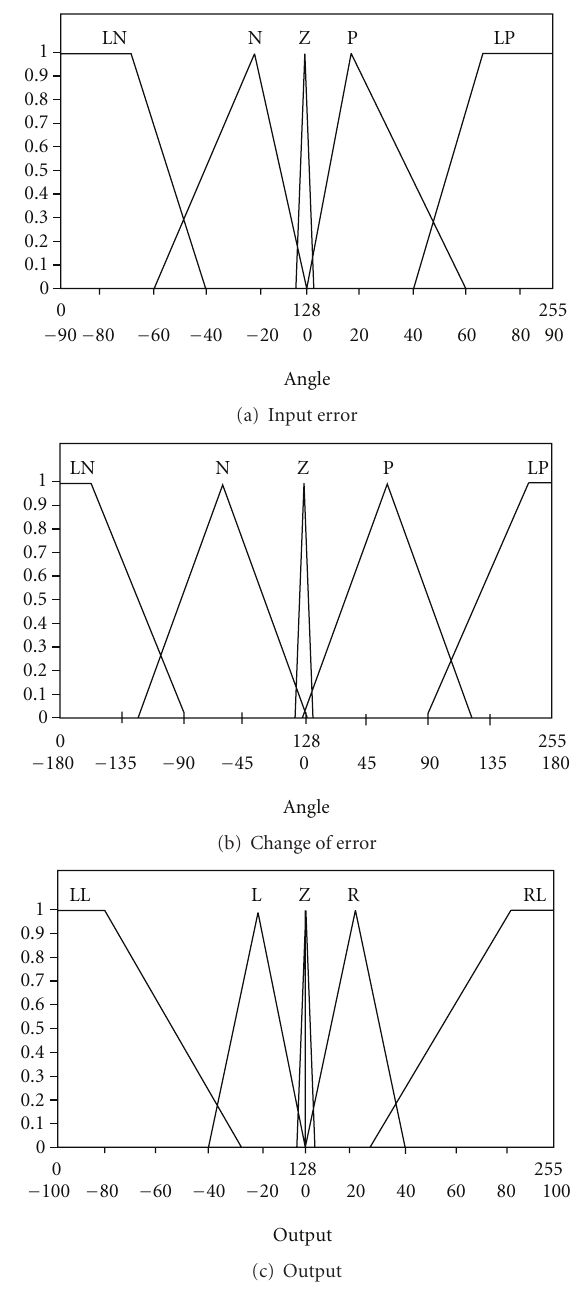
Figure 16: The FLC has two inputs: Error and Change of error, and one output. The output provides a value of increment/decrement to be used by the integral part of the PD+I controller. The first scale [0.255] are the real MFs bit values definition in the FLC. The second scale [ − 90, 90], [ − 180, 180], and [ − 100, 100] are the operation values for this application. The scale conversion is achieved by the ARM